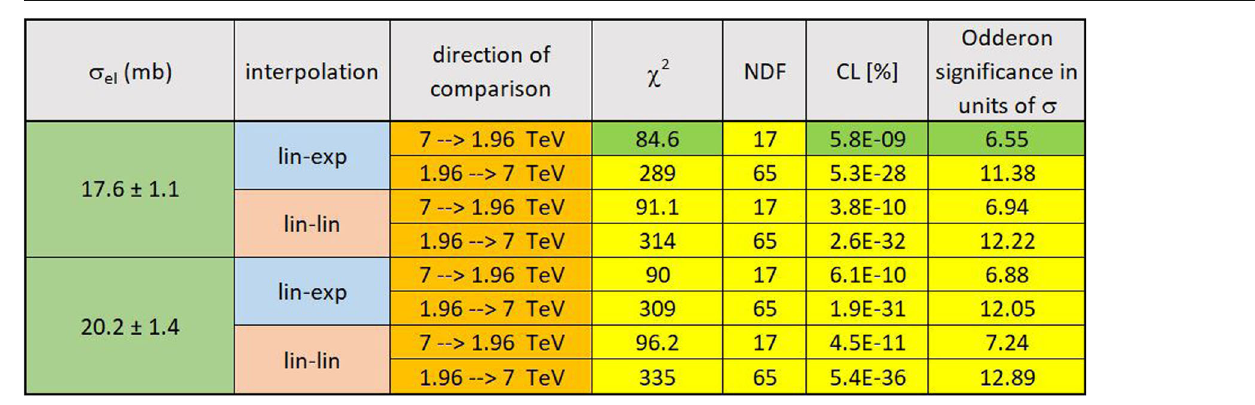
Table 2 Summary table of the significant Odderon signal in the one- tiny and negligible deviations are also seen between this table and the way comparison of the H ( x ) scaling functions of pp collisions at √ more precise values indicated in Fig. 10. This table indicates that the s = 7 TeV measured by the TOTEM experiment at the LHC, and Odderon signal is observed in this comparison with at least a 6.55 σ √ p ¯ p elastic collisions at s = 1 . 96 TeV measured by the D0 experiment at Tevatron. For the projection 1 . 96 → 7 . 0 TeV, very small confidence levels are obtained with CL < 10 − 27 %, and due to different rounding errors of the two different softwares that we utilized (Root vs Excel),